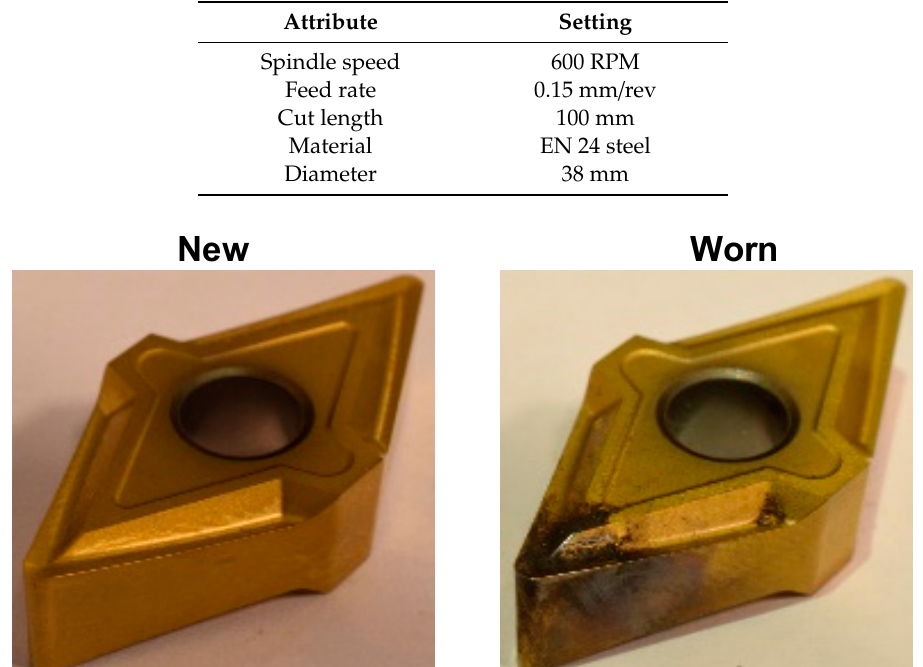
Figure 11. Visual representation of the new cutting tip ( left ) and worn cutting tip ( right ) used for the lathe tool wear investigation.